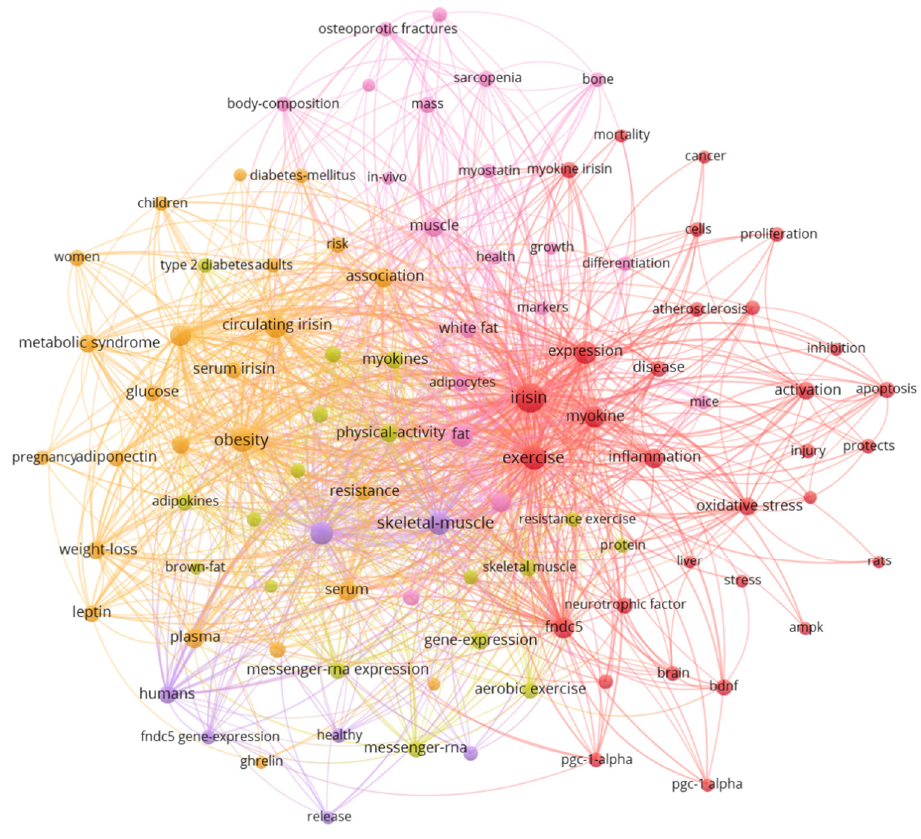
Figure 6. Co-occurrence network of high-frequency keywords in irisin research field. Table 4. Top 20 representative keywords in terms of occurrences.